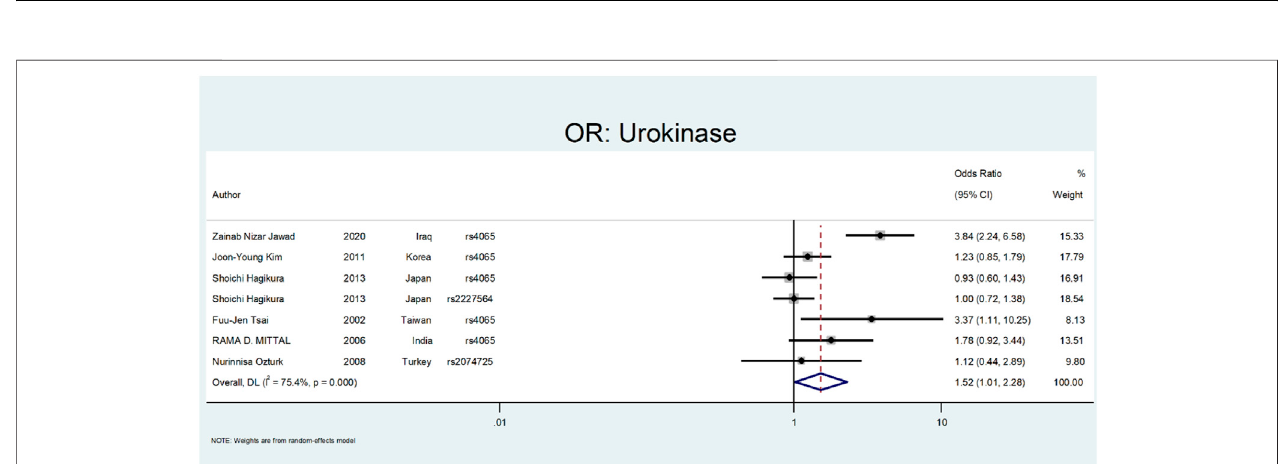
FIGURE 12 | Forest plot: OR for